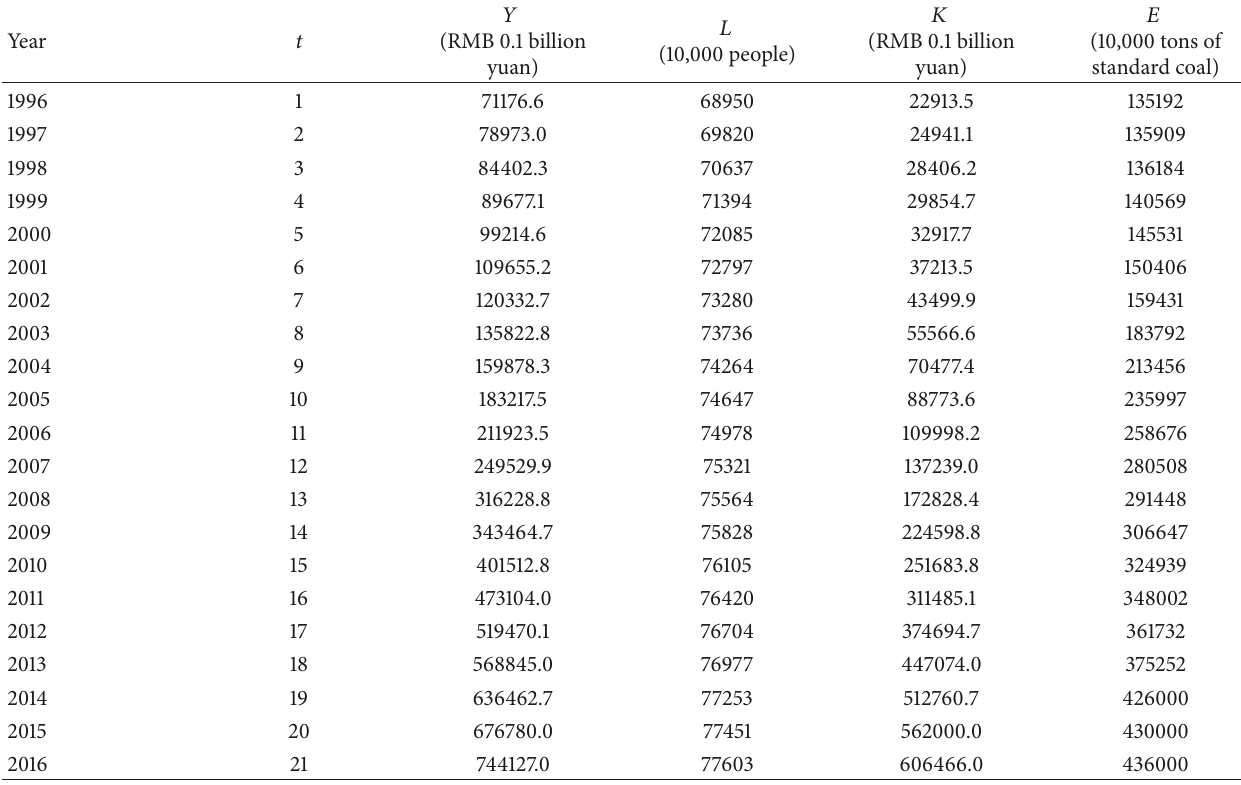
Table 1: Related data of Chinese economic